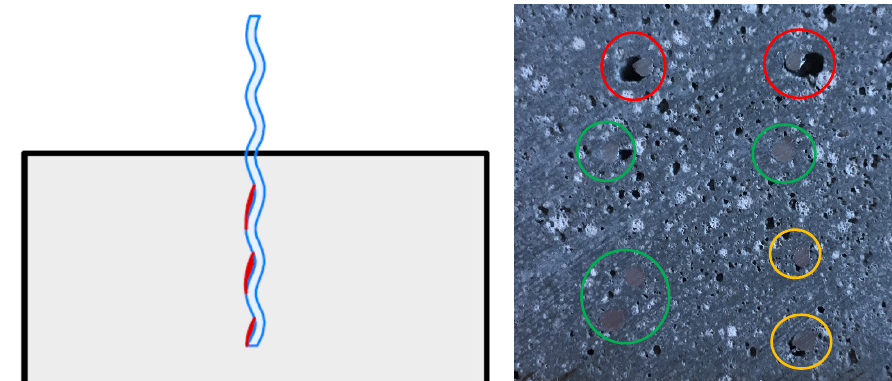
Figure 17. Schematical cavity formation around the vertically inserted fibers ( left ). Different quality of bond between fibers and mortar ( right —red: bad, yellow: satisfactory, green: good bond behavior).